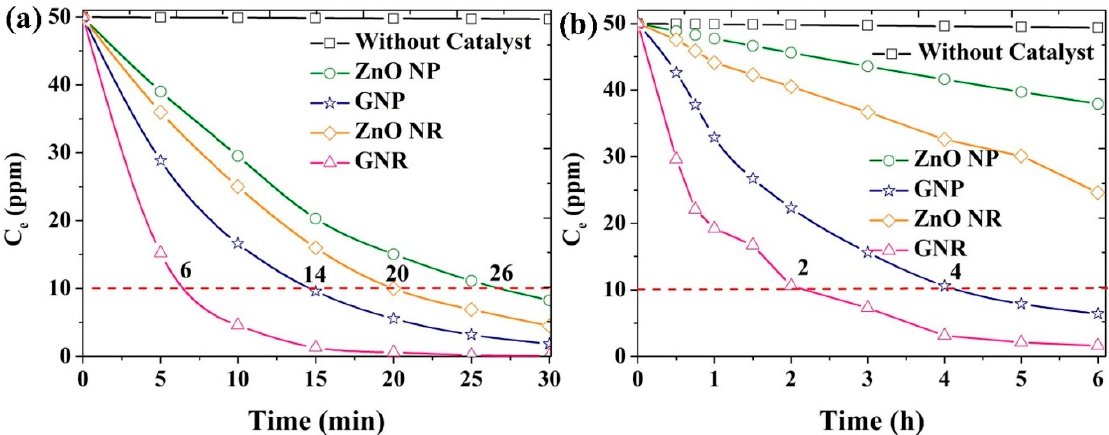
Figure 31. Photodegradation of methyl orange (MO) ( a ) under UV light, and ( b ) under visible light irradiation for ZnO NP, ZnO NR, ZnO NPs–graphene (GNP), and ZnO NRs–graphene (GNR). Reprinted with permission from [160] .